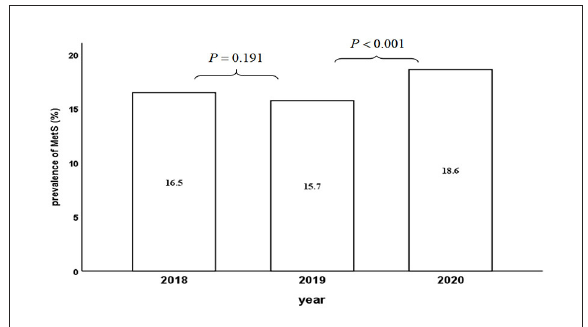
FIGURE2 Three-consecutive-year MetS prevalence of 3777 individuals.